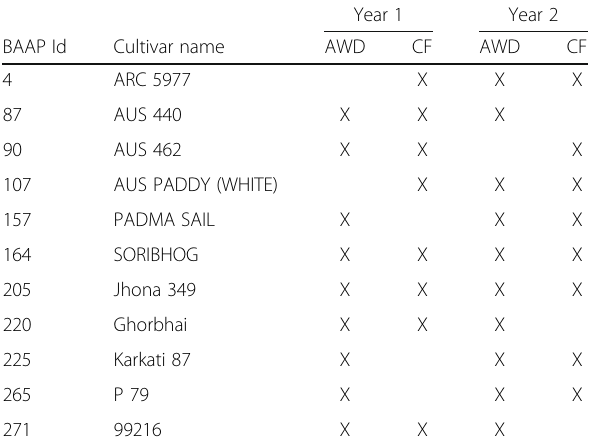
Table 3 Cultivars with consistently low grain arsenic in three or four of the experiments. An X indicates that that cultivar was in the lowest 10% for grain arsenic concentration in that